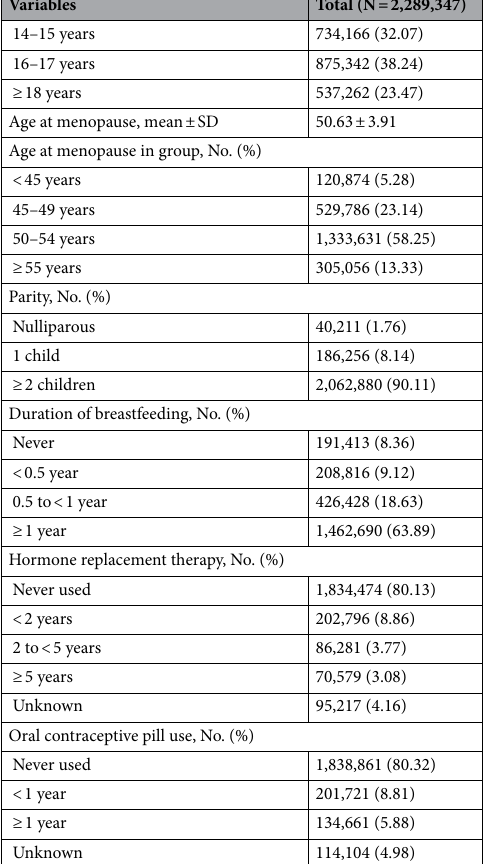
Table 1. Baseline characteristics of the study population. SD, standard deviation; Q,